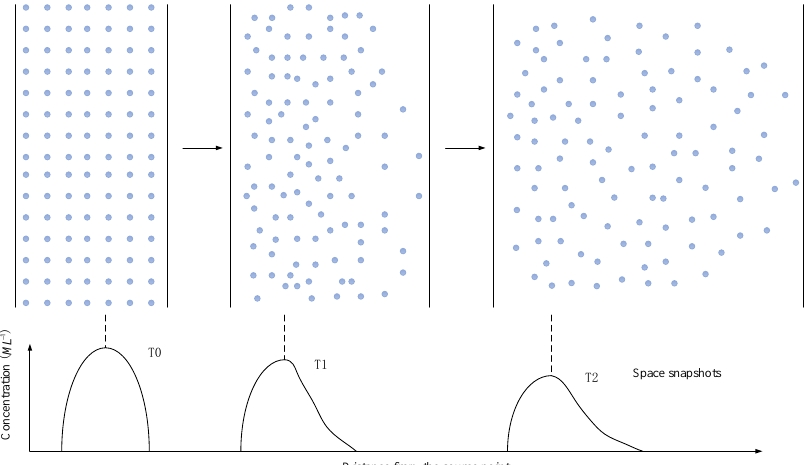
Figure 2. Conceptual map of the PDDO-based model and the non-local transport behavior (early arrivals and trailing edges) of pollutants in the framework of the PDDO-based model. Snapshots at T0 (start time), T1 and T2 times,